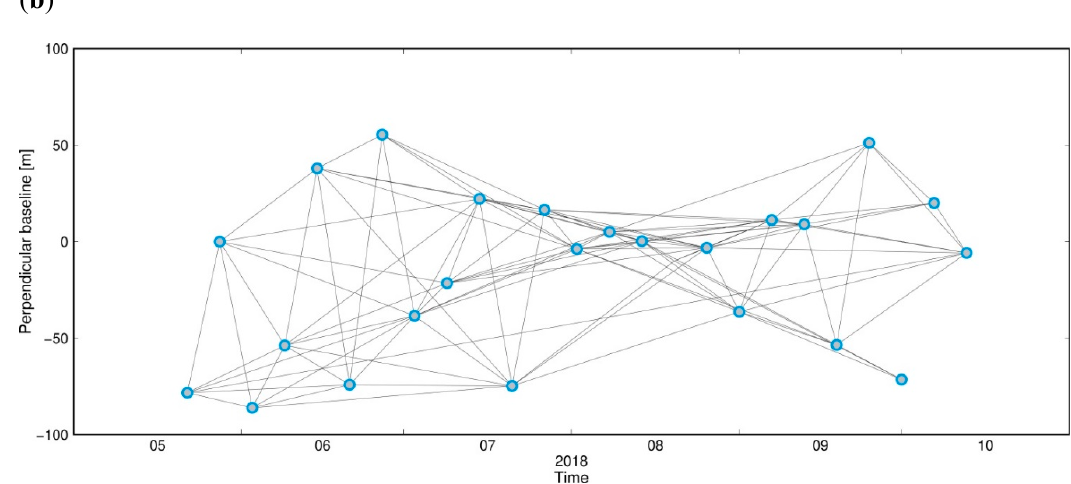
Figure A2. Baseline for tracks ( a ) 14 and ( b ) 154. Baselines used to calculate Line of Sight (LOS) displacements in each time period.